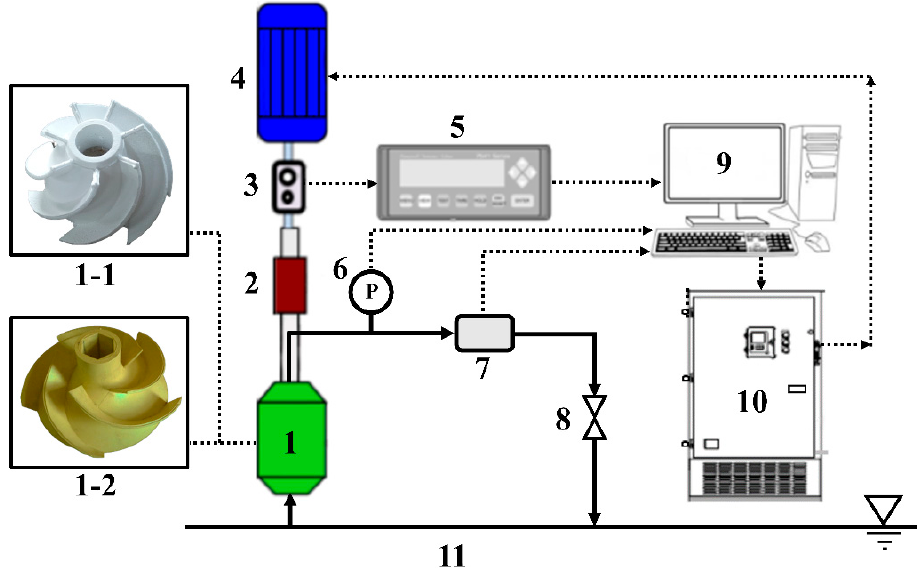
Figure 5. Test bench system: 1 . mixed-flow centrifugal pump, 1-1 . diffuser, 1-2 . impeller; 2 . shaft coupling; 3 . torque meter; 4 . motor; 5 . torque and RPM digital display; 6 . electronic pressure gauge; 7 . electromagnetic flowmeter; 8 . electric valve; 9 . computer; 10 . test control system; 11 . water pool.